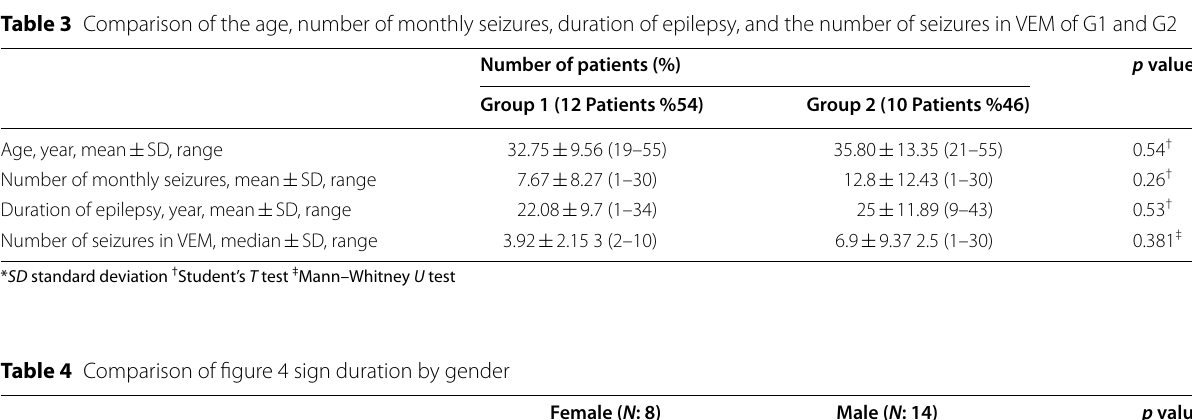
Table 4 Comparison of figure 4 sign duration by gender Female ( N : 8) Male ( N : 14) p value Figure 4 sign duration (second) mean SD, ±